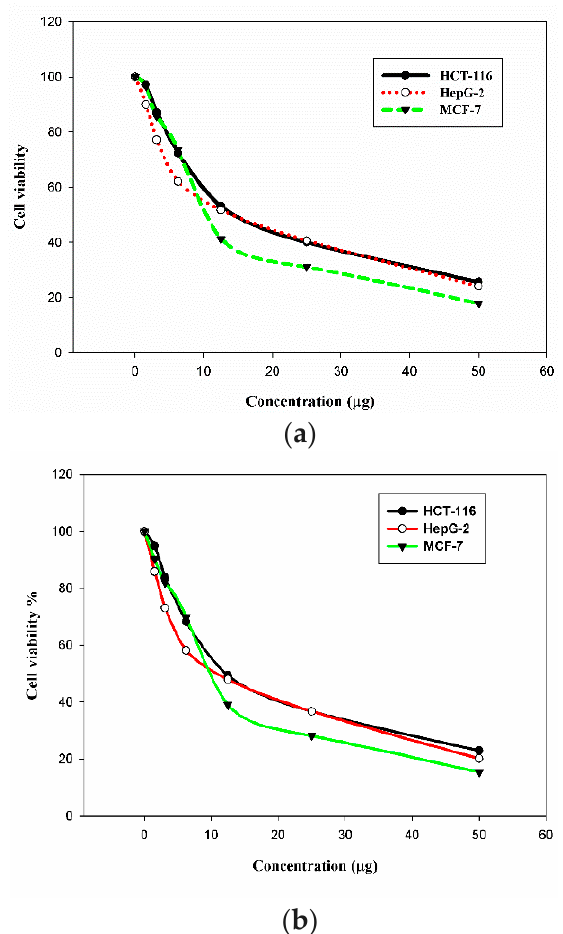
Figure 7. Cytotoxicity of the mallow leaf extract ( a ) and of its bio-functionalized Au NPs ( b ) in HCT-116, HepG-2, and MCF-7 cells. Table 4. Cytotoxicity of the mallow leaf extract in HCT-116, HepG-2, and MCF-7 cells, with IC 50 = 12.2, 10.3, and 11.2 µg/mL, respectively. Sample